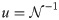
Iterated map at tangency.The map parameters are z = α = 2, the curvature is u = 0.0125, and the trajectory xt, t = 0, 1, 2, … t, is initiated at x0 as given by Eq (28). Also shown is the area At (shaded) as given by Eq (29). The map properties translate into the equivalent description of the rank distributions N(k) and F(k′) via the identifications t = k, u=N-1, xt = −N(k) = k′, x0 = −Nmax and At=F(k′/N). See text for description.